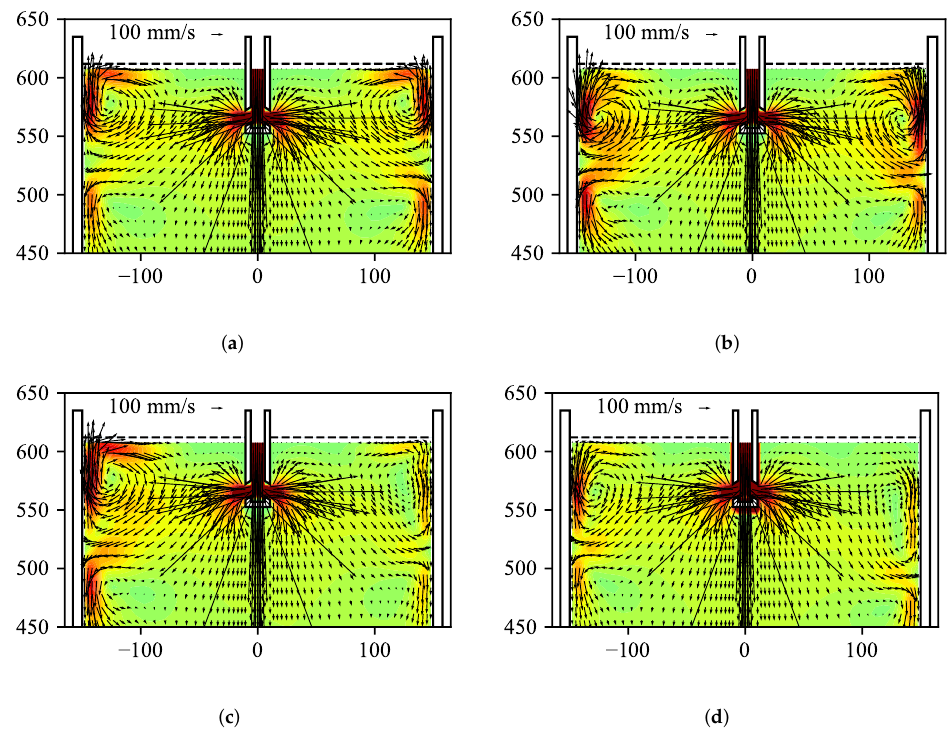
Figure 5. Reconstructed velocity fields in the center xz-plane of the mould for different experi- mental configurations. ( a ) No clogging; I EMBr = 0 A. ( b ) No clogging; I EMBr = 200 A. ( c ) With clogging; I EMBr = 0 A. ( d ) With clogging; I EMBr = 200 A.